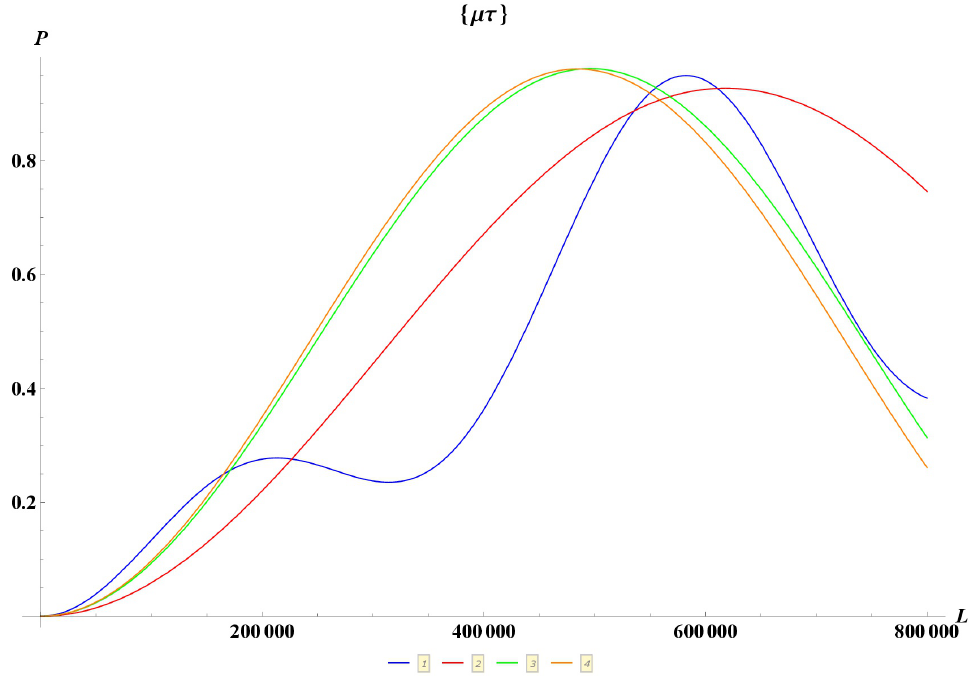
Figure 9. Same analysis of Figure 8, but for the case of P ν